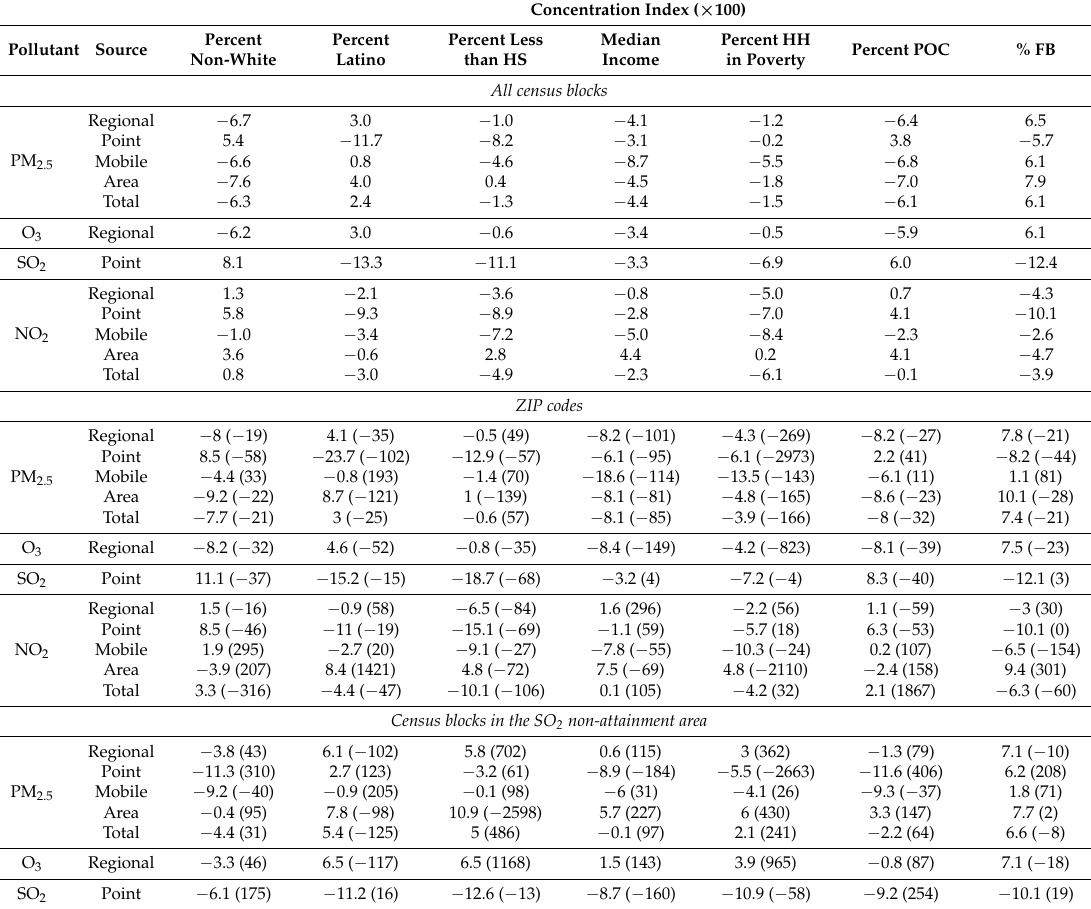
Table 4. Concentration index values ( × 100) for annual risk of a DALY per year attributable to individual pollutants for the full analysis, and for sensitivity analyses of spatial resolution and region. Negative values indicate disproportionately high health burdens in socially disadvantaged spatial units. Percentages (in parentheses) show change from “all